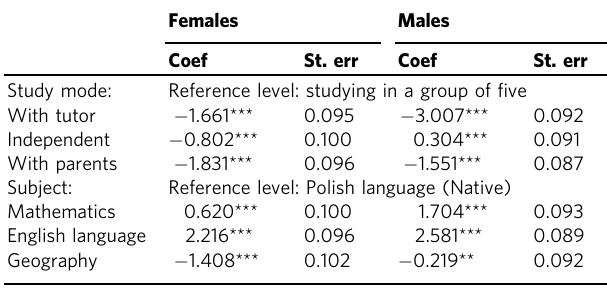
Table 5 Willingness to pay (in hours) for males and females. Table 3 Average willingness to pay for the study mode and